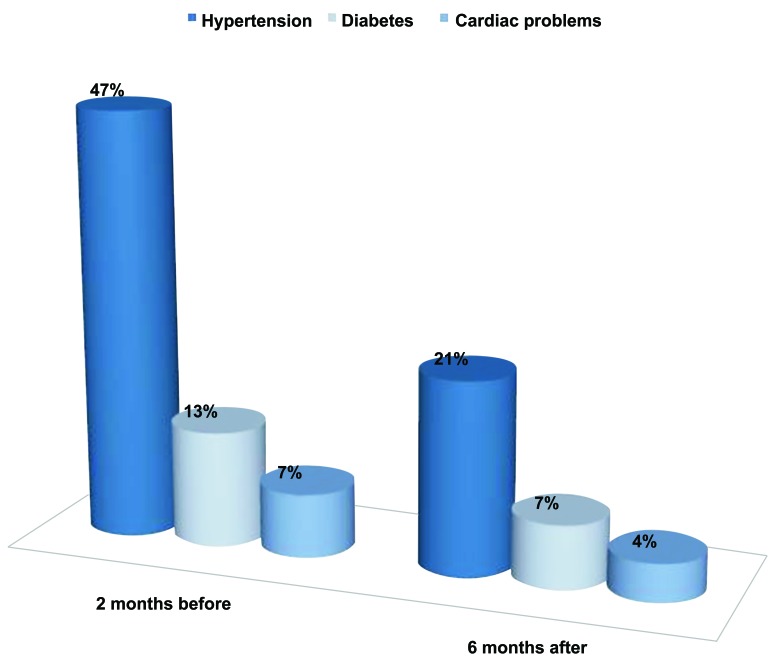
Diseases associated with obesity.